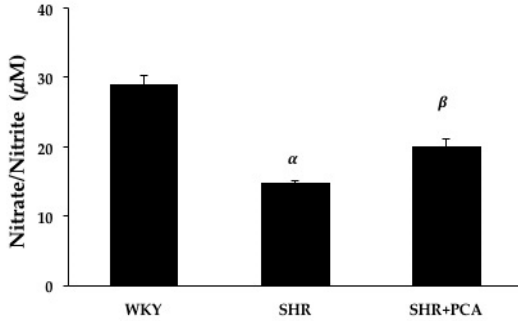
Figure 5. Serum nitrate/nitrite concentration among the WKY, SHR, and SHR+PCA groups. α , p < 0.05, significant differences from WKY; β , p < 0.05, significant differences from SHR; n = 8 in each group.